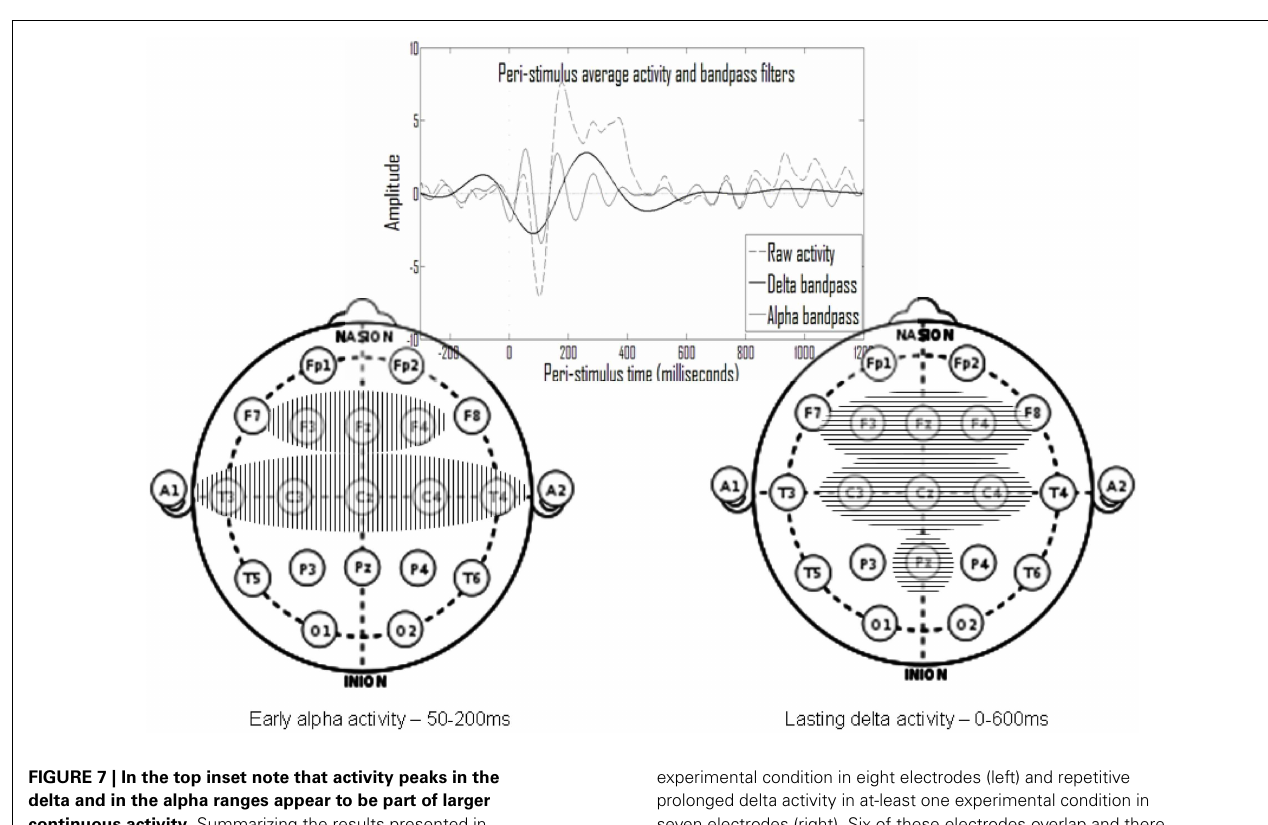
FIGURE 7 | In the top inset note that activity peaks in the delta and in the alpha ranges appear to be part of larger continuous activity . Summarizing the results presented in Figure 6 , there is repetitive early alpha activity in at-least one